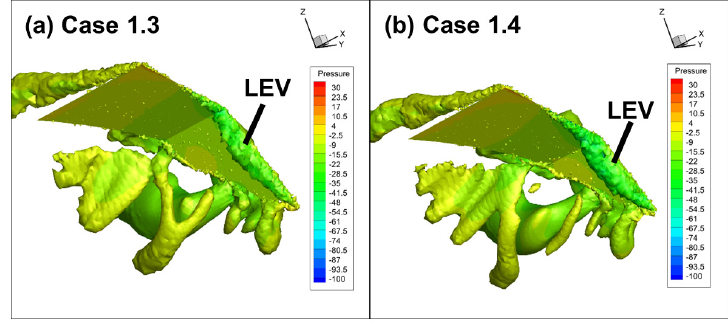
Figure 10. Vorticity of typical cases at t* = 0.55: ( a ) case 1.3; ( b ) case 1.4.